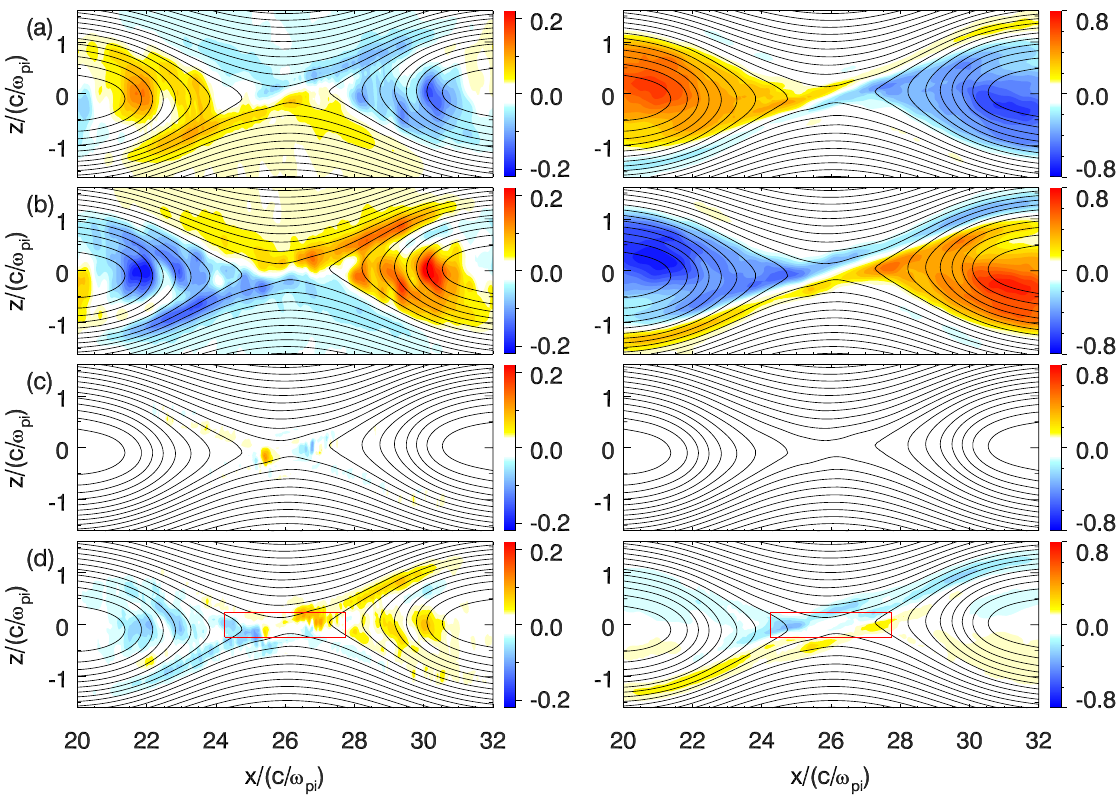
Fig. 6. (a) The electric field force − en e E , (b) the Ampere force j e × B , (c) the pressure gradient −∇· P e , and (d) the sum of the above three forces at (cid:127) i t = 25. The left (right) panels show the x(z) component of the forces.